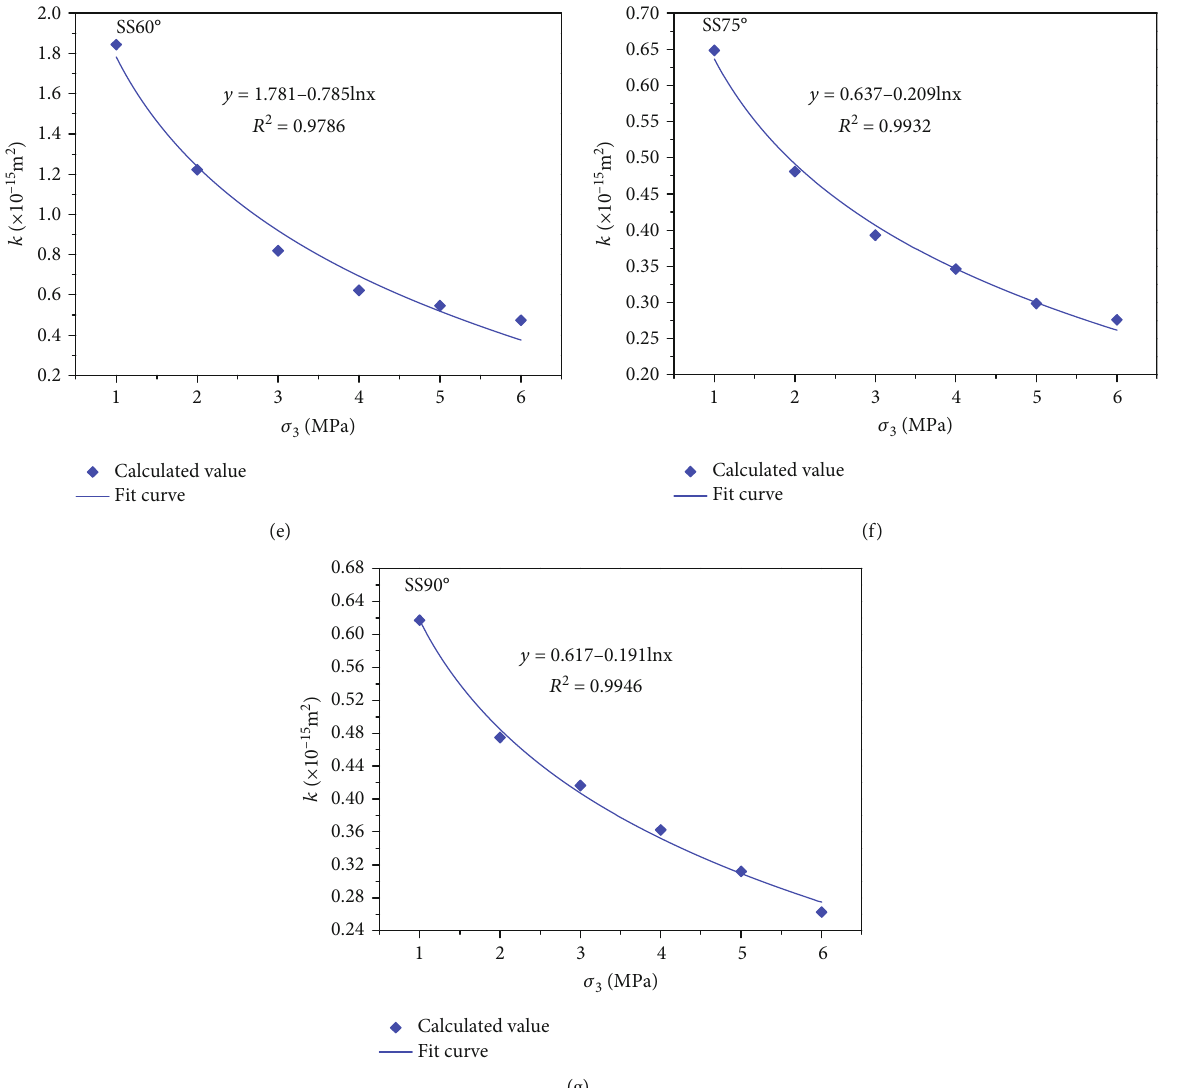
Figure 11: Relationship between the intrinsic permeability k and the minimum principal stress σ